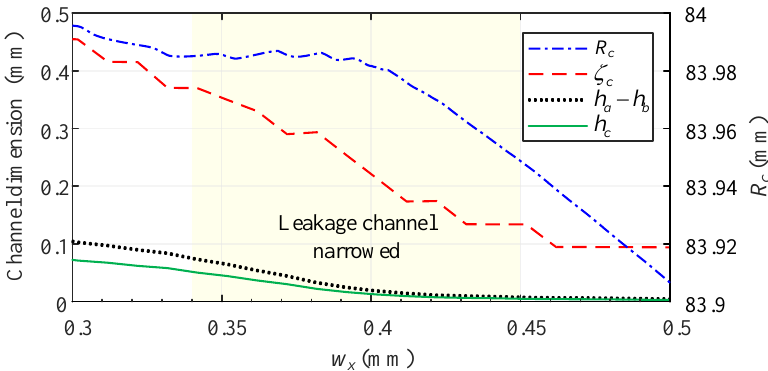
Figure 16. Leakage channel dimension and sealing radius as a function of base deflection.